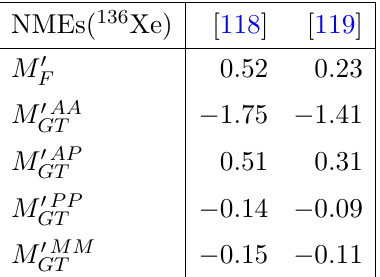
Table 8 . Comparison of the derivative of 136 Xe NMEs with respect to m 2 random phase approximation [118] and shell model [119]. The NMEs are de(cid:12)ned in eq. (6.13).